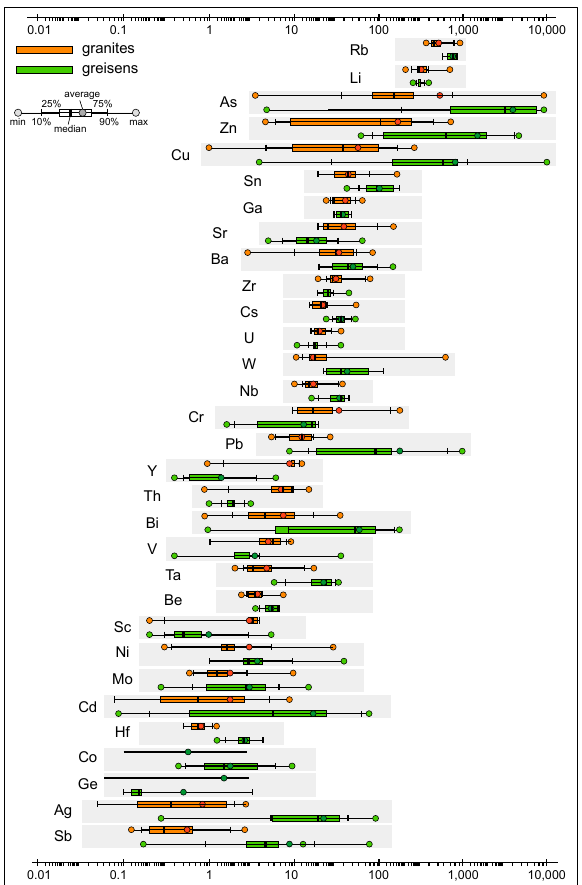
Figure 26. Box-plot of minor and trace element distribution in the Panasqueira granites and greisens (in ppm, log. scale).